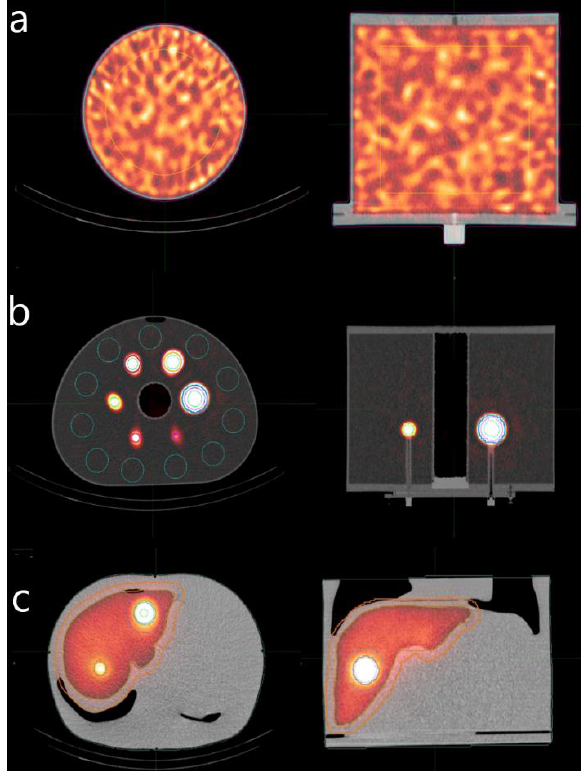
Figure 4. A transaxial and coronal cross-section of the used phantoms: ( a ) cylindrical phantom, ( b ) NEMA/IEC NU2 phantom, and ( c ) Abdo-Man anthropomorphic phantom.